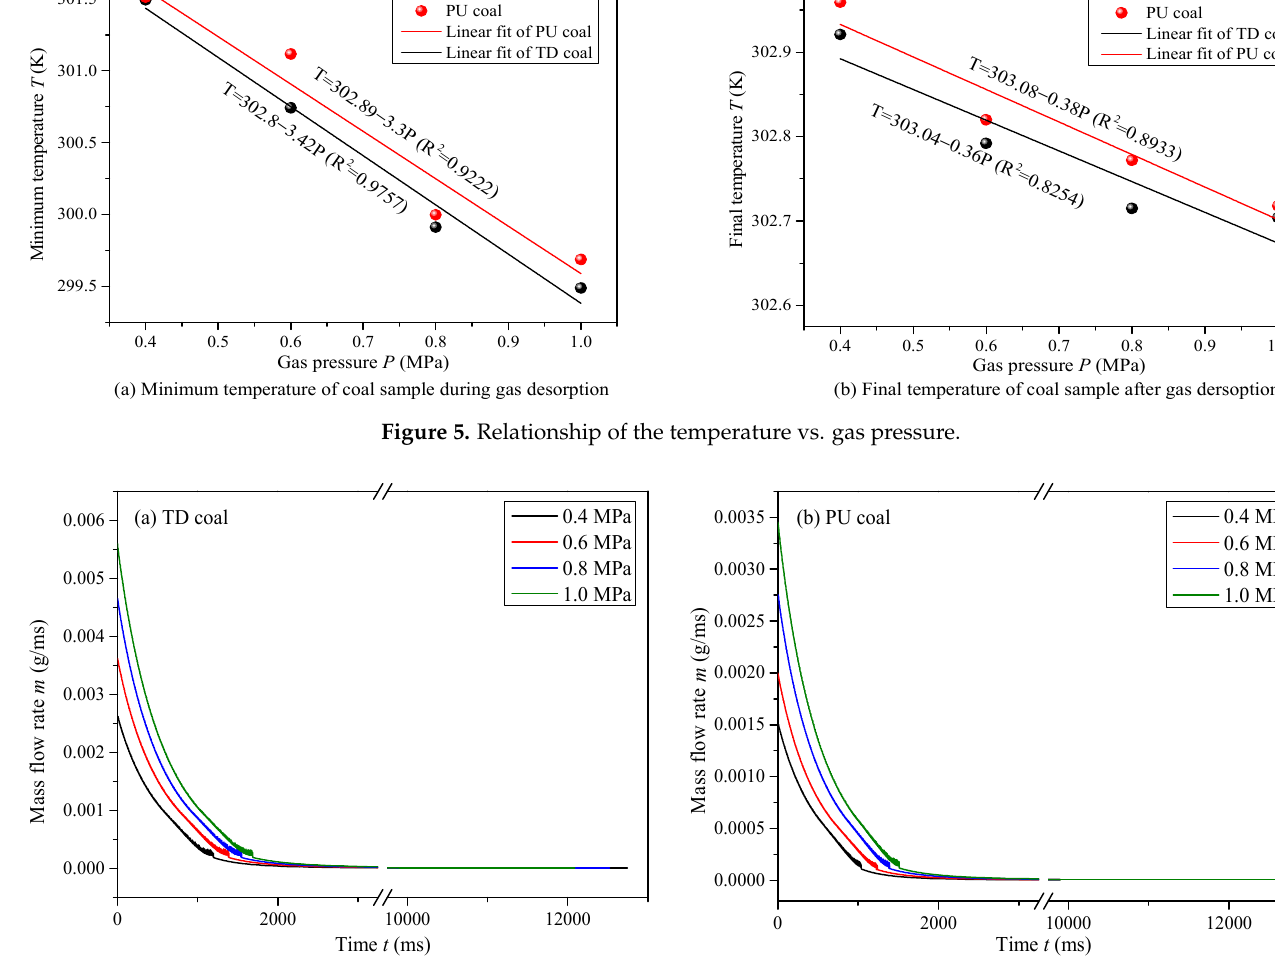
Figure 6. Change curve of mass flow rate vs. time during gas initial desorption of coal particles.